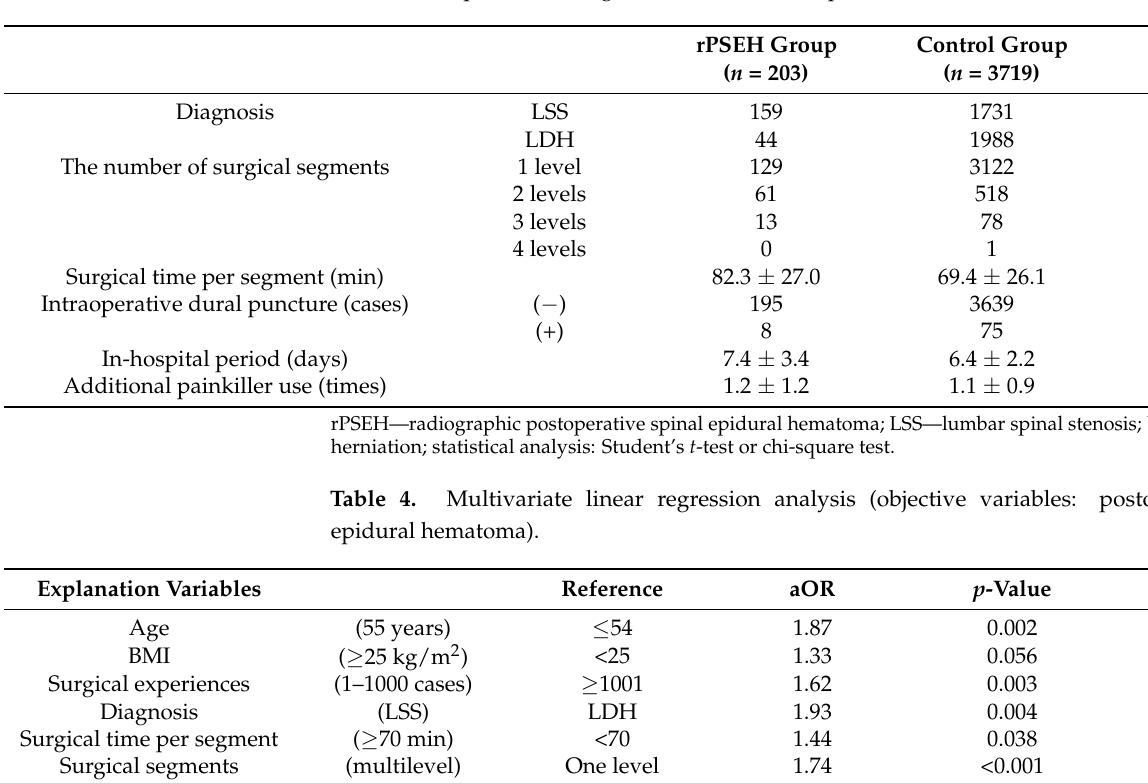
Table 3. Comparison of surgical data between the patients with and without rPSEH.